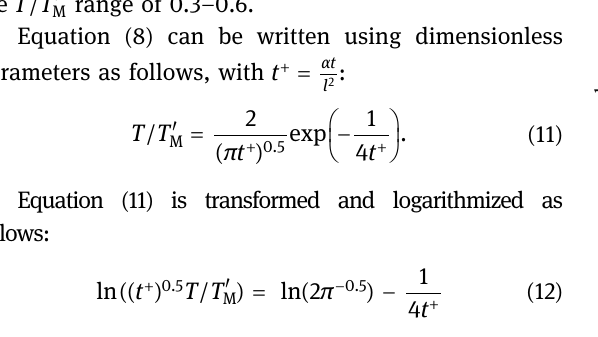
Figure 3: Biot number dependence of slope =